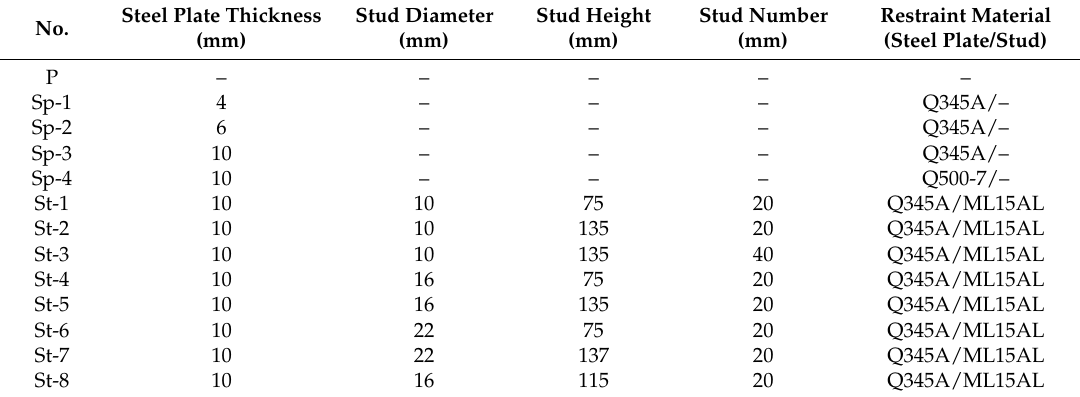
Table 3. List of experiments.